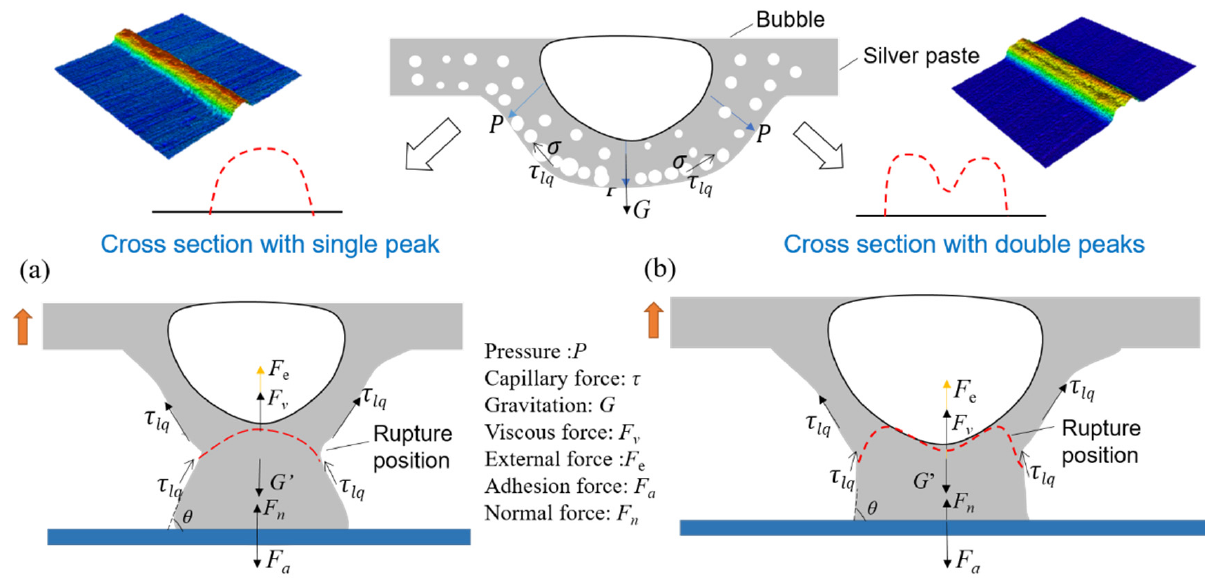
Figure 9. Schematic diagram of the forces on the silver paste at the bottom of the bridge during the transfer process. ( a ) forces on the silver paste when the laser fluence was at critical transfer threshold, ( b ) forces on the silver paste when the laser fluence was above transfer threshold.